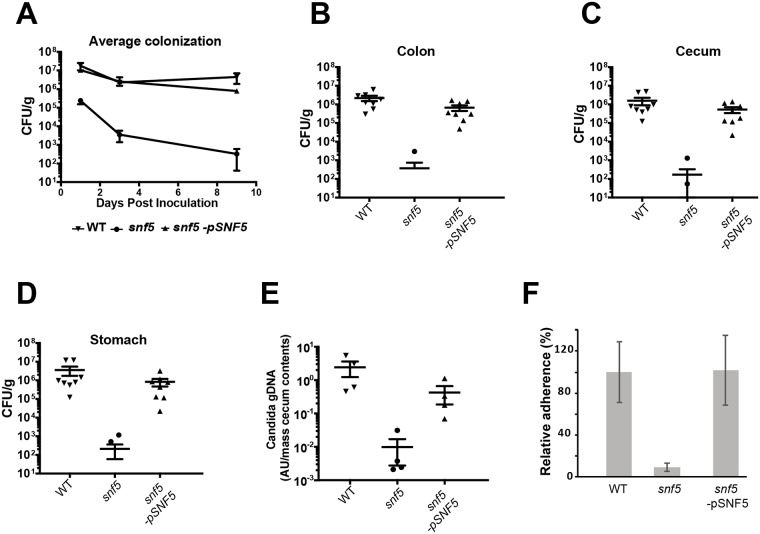
Snf5 is required for adherence to human enterocytes and intestinal colonization.Antibiotic-treated mice were orally inoculated by WT, snf5 and the complemented strain. (A) Intestine colonization was followed after 1, 3- and 9-days post-inoculation by determining the CFU from fresh fecal pellets. At day 10, the mice were sacrificed, and the degree of colonization was measured in the stomach (B), the cecum (C) and the colon (D). Multiple means were compared using Dunn’s multiple comparison test and snf5 colonization defect is statistically significant as compared to the WT or the complemented strain. (E) qPCR validation of the colonization defect of snf5 in the cecum. (F) Adherence of the WT, snf5 and the revertant strains to the HT-29 enterocytes. The adhesion was calculated as % of cells that remain attached to HT-29 cells after PBS rinsing relative to the C. albicans WT strain. The presented results are from at least three independent experiments performed in triplicate.